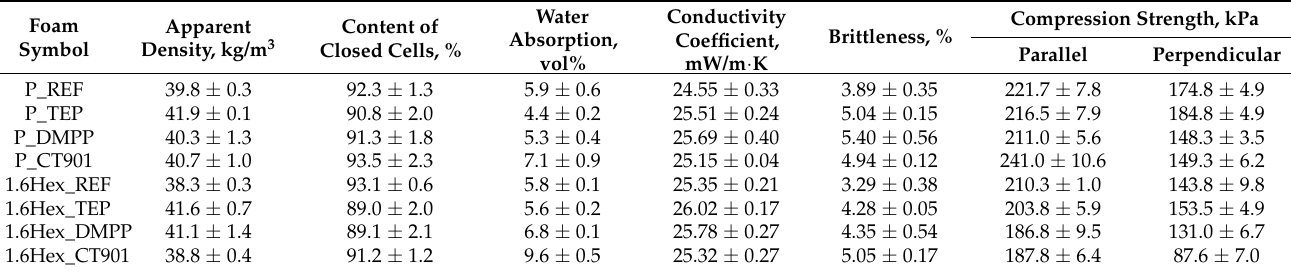
Table 4. Selected physical and mechanical properties of